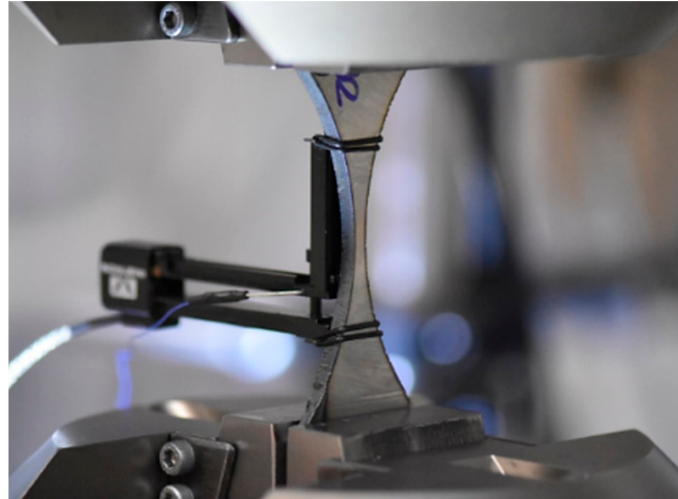
Figure 3. U-notched specimen and the 2620-601 extensometer in the 8802 Instron testing machine before the tensile test.